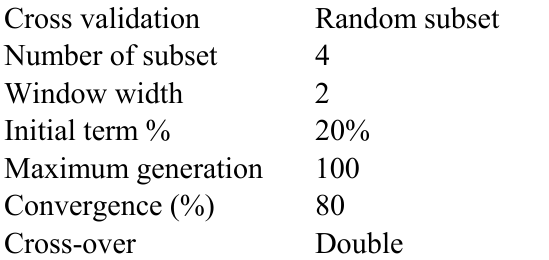
Table 14. Parameters of genetic algorithm